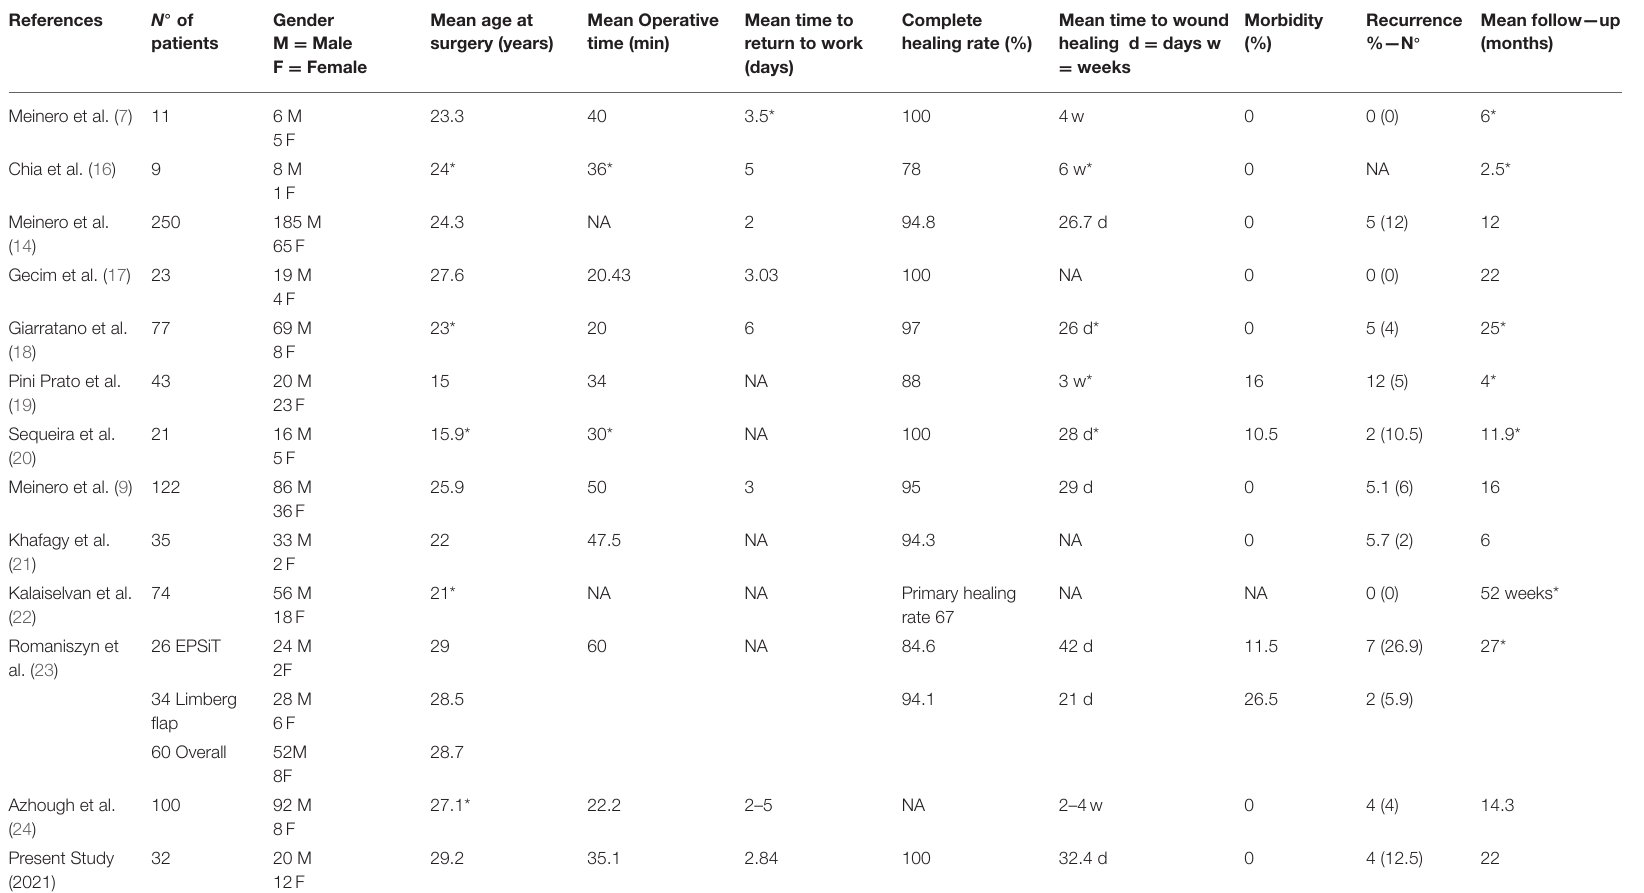
TABLE 5 | Patient details, procedural results and follow-up data of the EPSiT in the